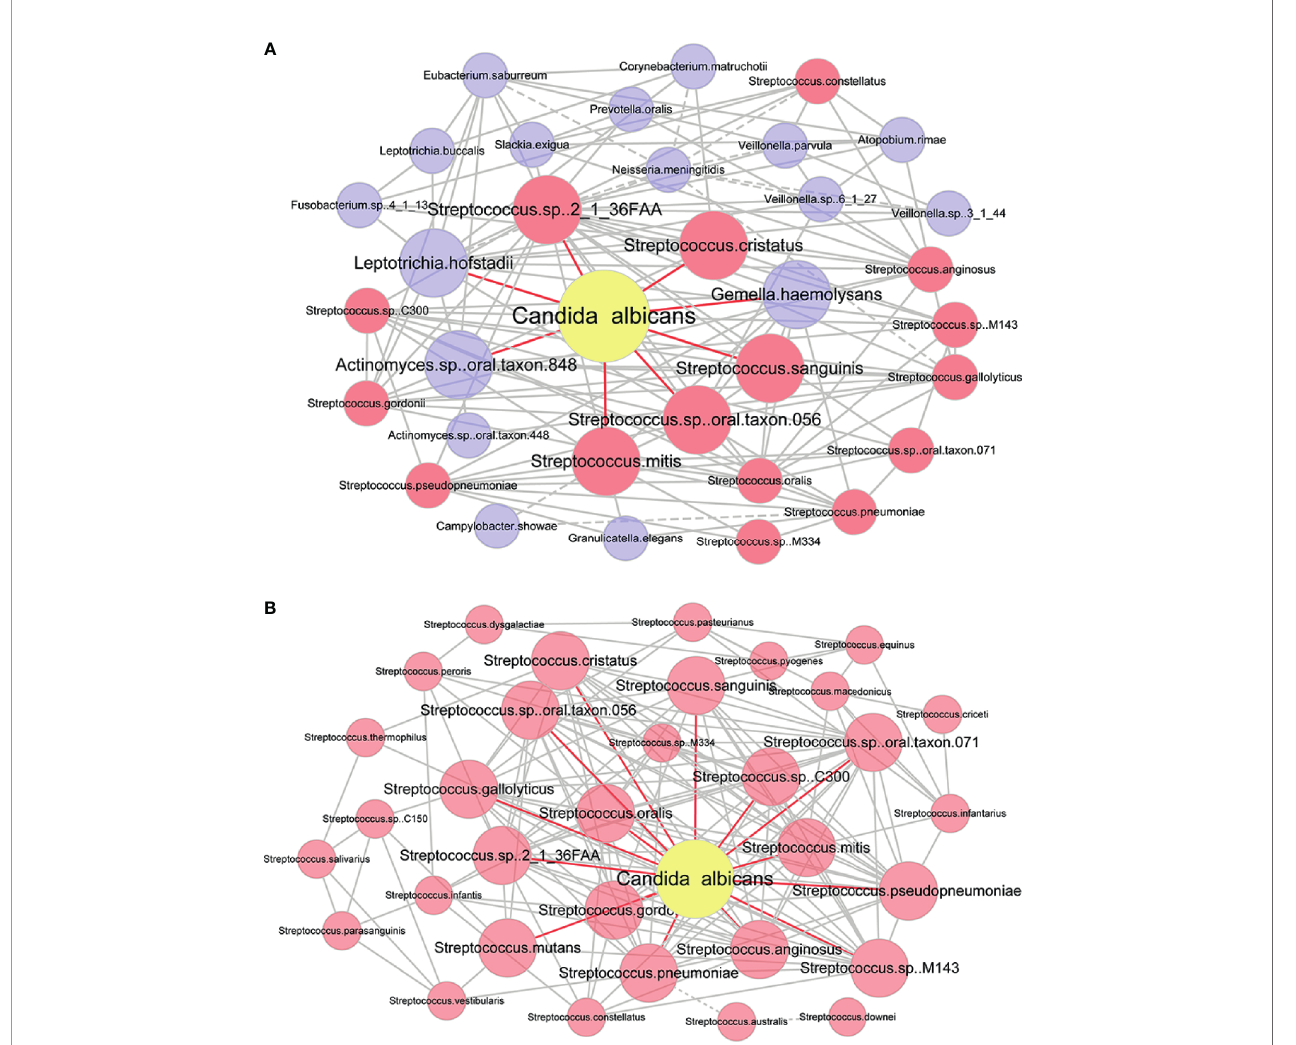
FIGURE 4 | Co-occurrence network of C. albicans and bacteria. (A) Co-occurrence network modules formed around C. albicans . Taxa that were directly correlated with C. albicans and those directly corrected with them were used to construct the network. Each pair of nodes connected by an edge was signi fi cantly and highly correlated (Spearman correlation test, P < 0.05, |r| ≥ 0.6). Solid and dashed lines indicate positive and negative correlations. Taxa that were directly correlated with C. albicans are in bold. Nodes that represent members of Streptococcus are highlighted in red. (B) Co-occurrence network of C. albicans and Streptococcus spp. Each pair of nodes connected by an edge was signi fi cantly and highly correlated (Spearman correlation test, P < 0.05). Solid and dashed lines indicate positive and negative correlations. Taxa that were directly correlated with C. albicans are in